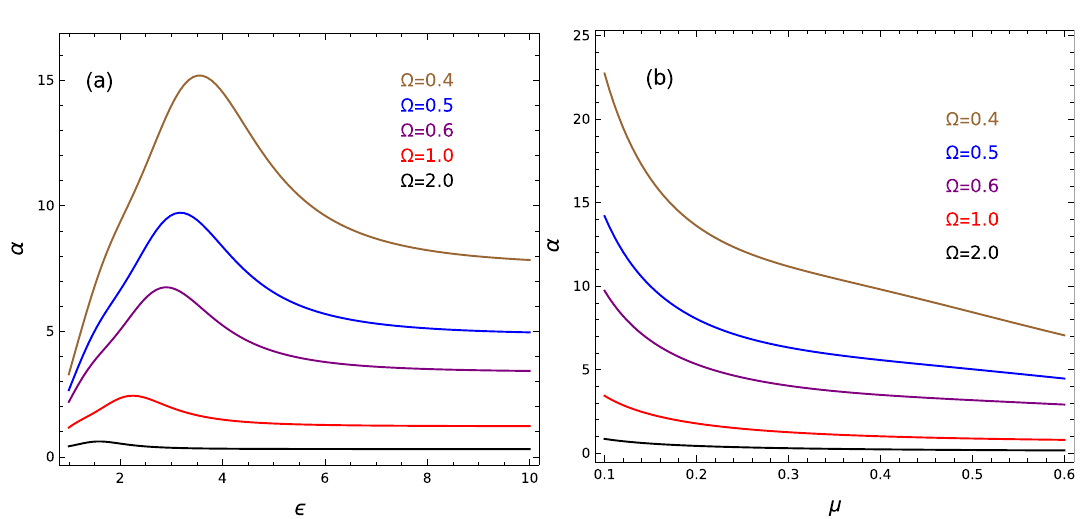
Figure 5. Ground state static dipole polarizabilities (in units of a 3 0 ) of Mott-Wannier exciton for isotropic confinement ( a = 1 ) for several values of confinement strength ( (cid:31) ): ( a ) dependence on electric permittivity with fixed reduced mass of the system µ = 0.28 ; ( b ) dependence on reduced mass with fixed electric permittivity ε = 5